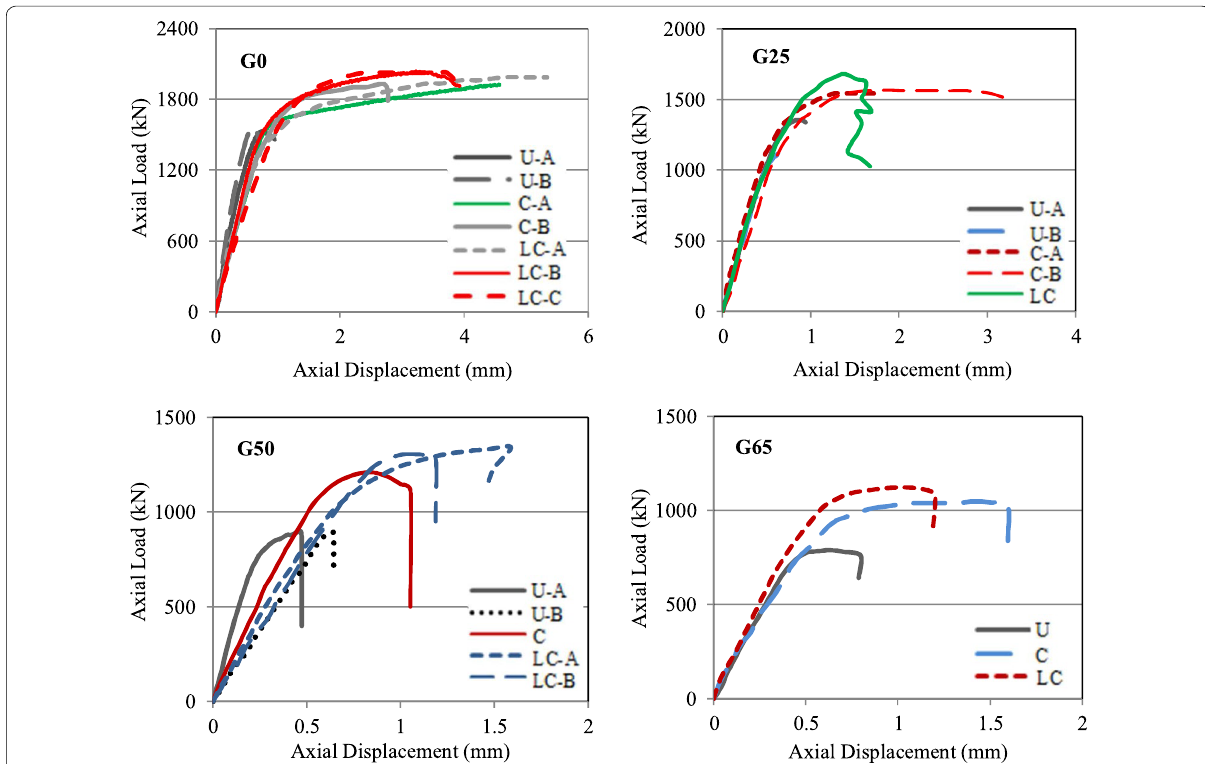
Fig. 3 Experimental axial load–displacement relations of G0, G25, G50 and G65 columns.